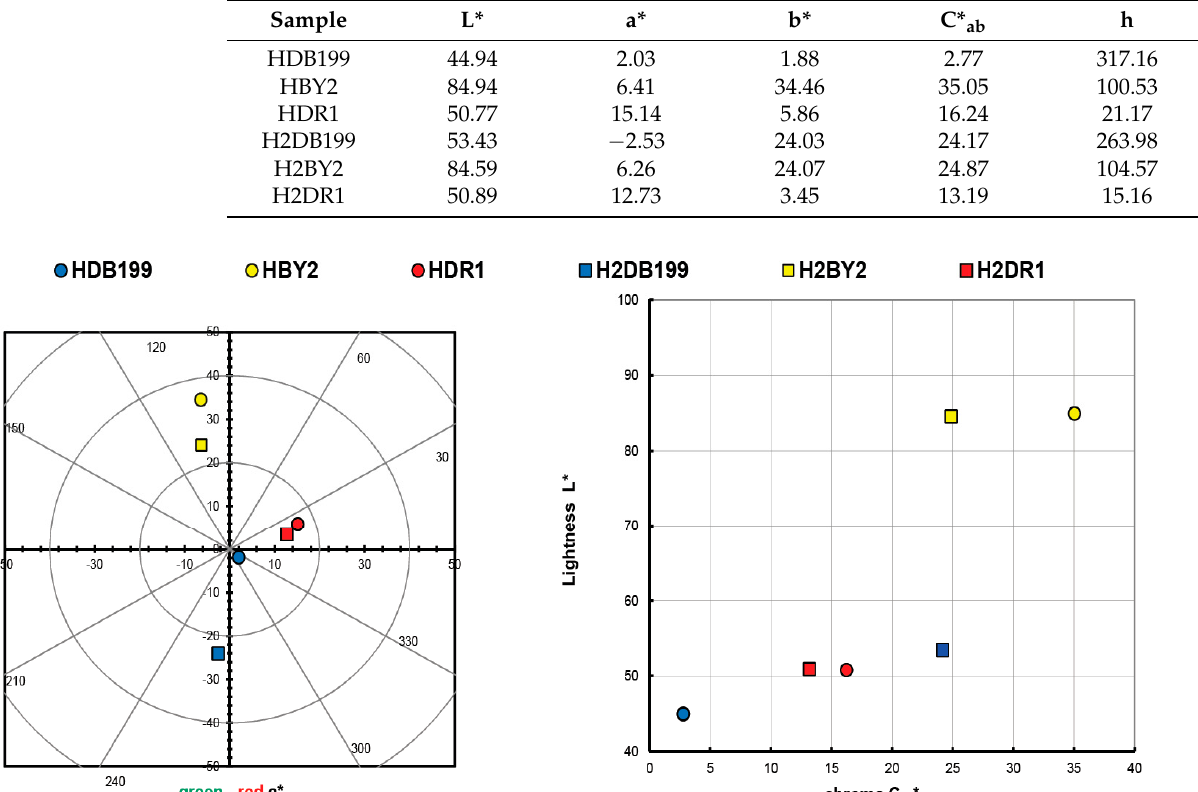
Table 2. Values L*, a*, b*, C* ab and h of each hybrid.